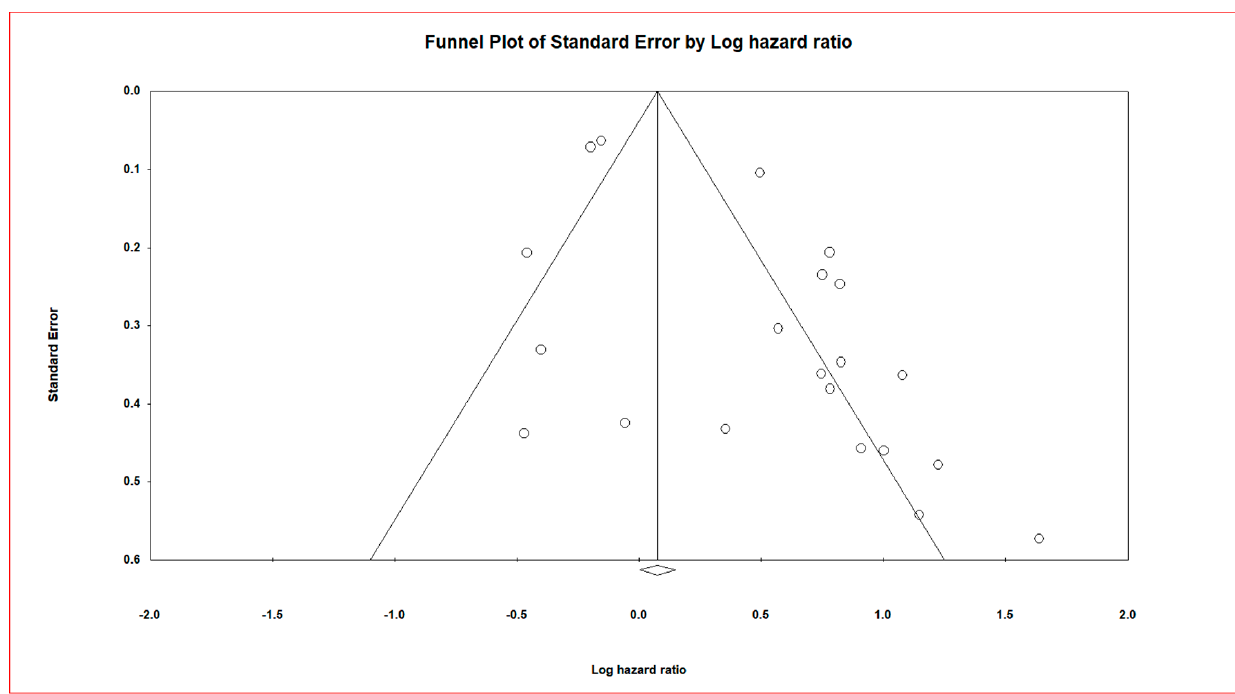
Figure 3. Funnel plot of Standard Error by Log hazard ratio correlating patient survival in general and microRNA expres- sion.